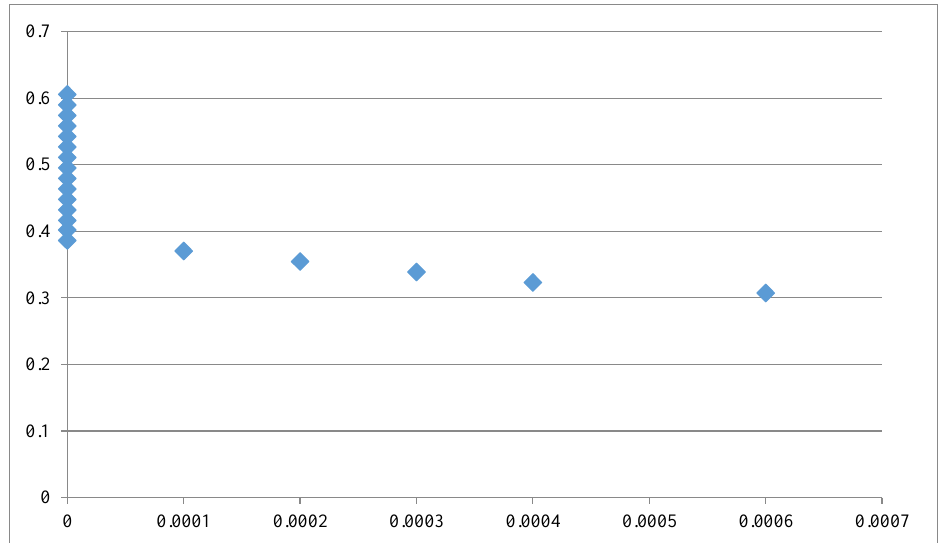
Figure 3. Efficient frontier of LPM model with Rnec= 20%.